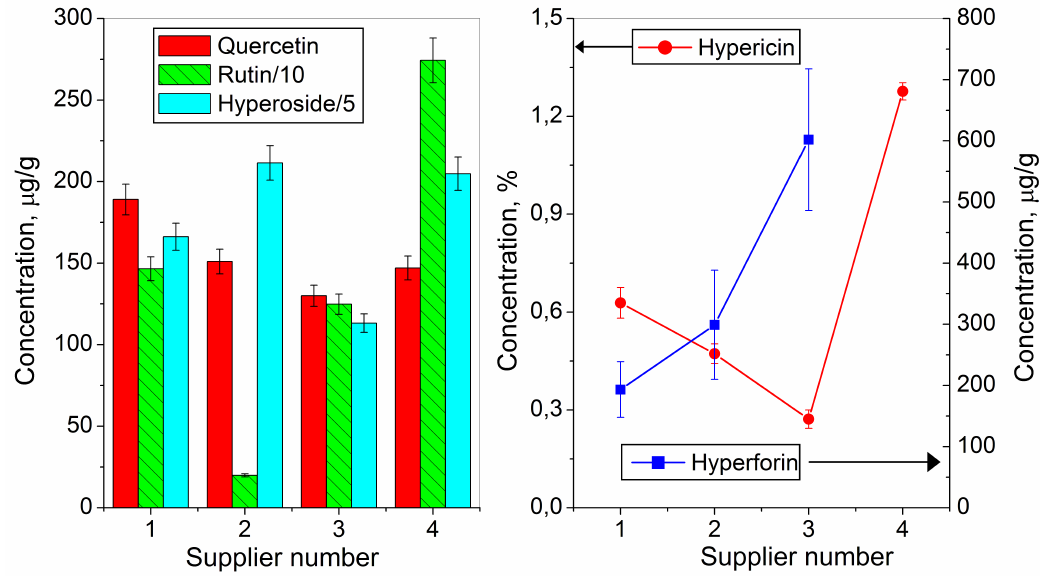
Figure 58: Presentation of paper